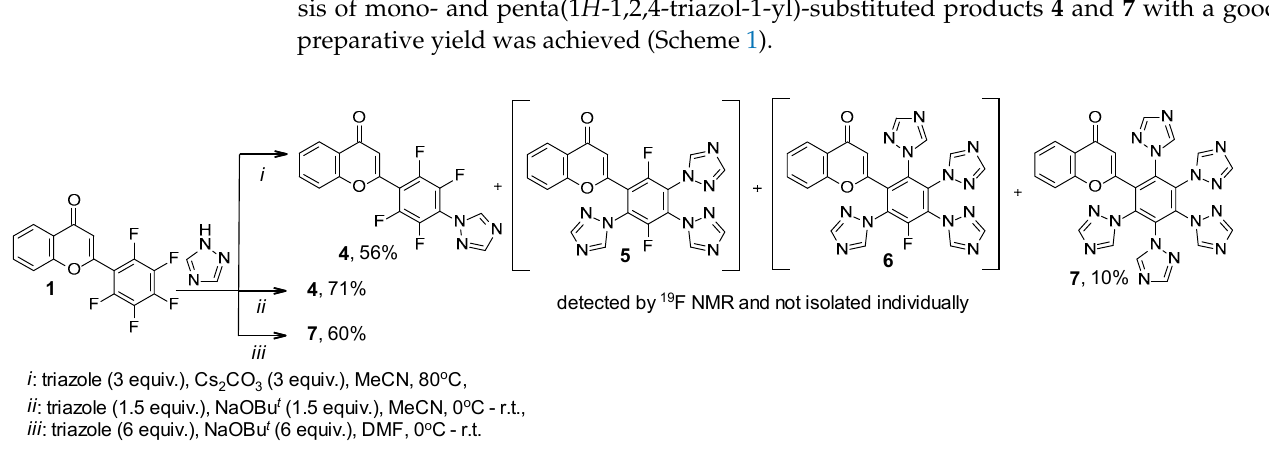
Table 1. 19 F NMR data of mixture of Cs 2 CO 3 -promoted reaction of flavone 1 with 1 H -1,2,4-triazole. 19 F NMR Data Compound δ , ppm Products Ratio, % 16.66, m; 24.82, m 15.95, m; 26.03, m; 26.86, m 31.53, m 2 In contrast to the transformations with triazole, the reaction of flavone 1 with 3 equiv. of imidazole under the same conditions resulted in the formation of mono-, di-, and tri(1 H -imidazol-1-yl)-substituted products 8 – 10 , which were isolated with a poor prepar- ative yield. The 19 F NMR data of fluorine-containing products 8 – 10 and their ratio in the mixture are shown in Table 2. Under conditions preferable to monosubstitution, 2- [2,3,5,6-tetrafluoro-4-(1 H -imidazol-1-yl)phenyl]-4 H -chromen-4-one 8 was synthesized with a good yield (Scheme 2). In addition, under conditions conducive to the formation of a persubstituted product, the reaction of these reagents is extremely nonselective. Table 2. 19 F NMR data of a mixture of Cs 2 CO 3 -promoted reaction of flavone 1 with imidazole. 19 F NMR Data Compound δ , ppm, J , Hz Products Ratio,